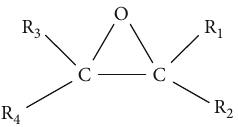
Figure 1: Structural formula of the epoxy (oxirane) group.